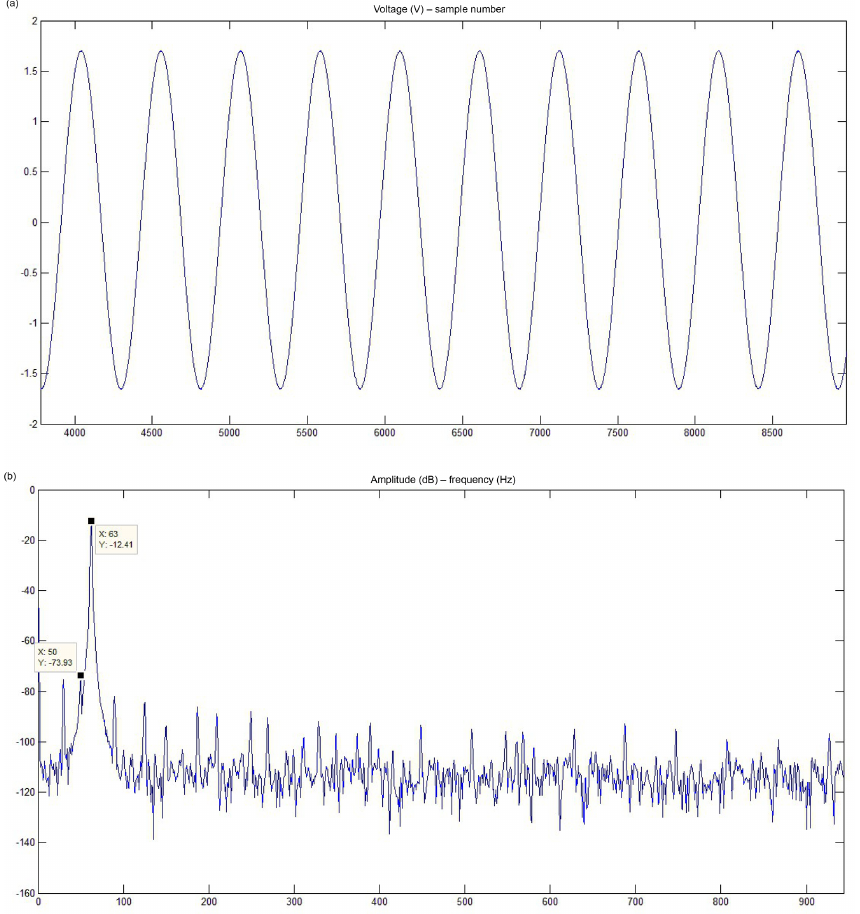
Figure 10. Test results of the low-speed current acquisition channel. (a) Time domain waveform of the 150mVpp, 62.5Hz sinusoid acquired by the low-speed current recording device at a 50A level. (b) Amplitude-frequency characteristics of the 32000 samples subjected to FFT (Hanning window